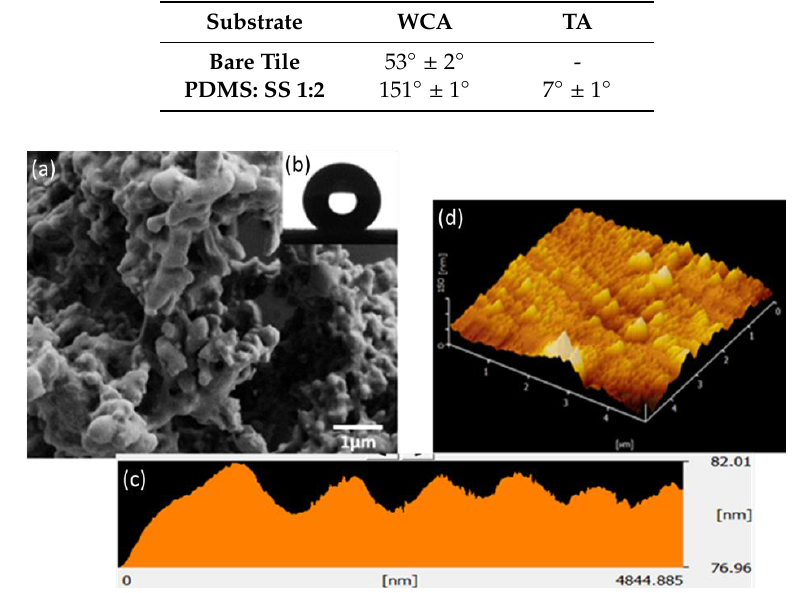
Figure 1. ( a ) FESEM image; ( b ) WCA; ( c ) AFM line profile and ( d ) 3D AFM topographical images of coated samples with PDMS: SS 12.5 mg/L showing hydrophobicity features.